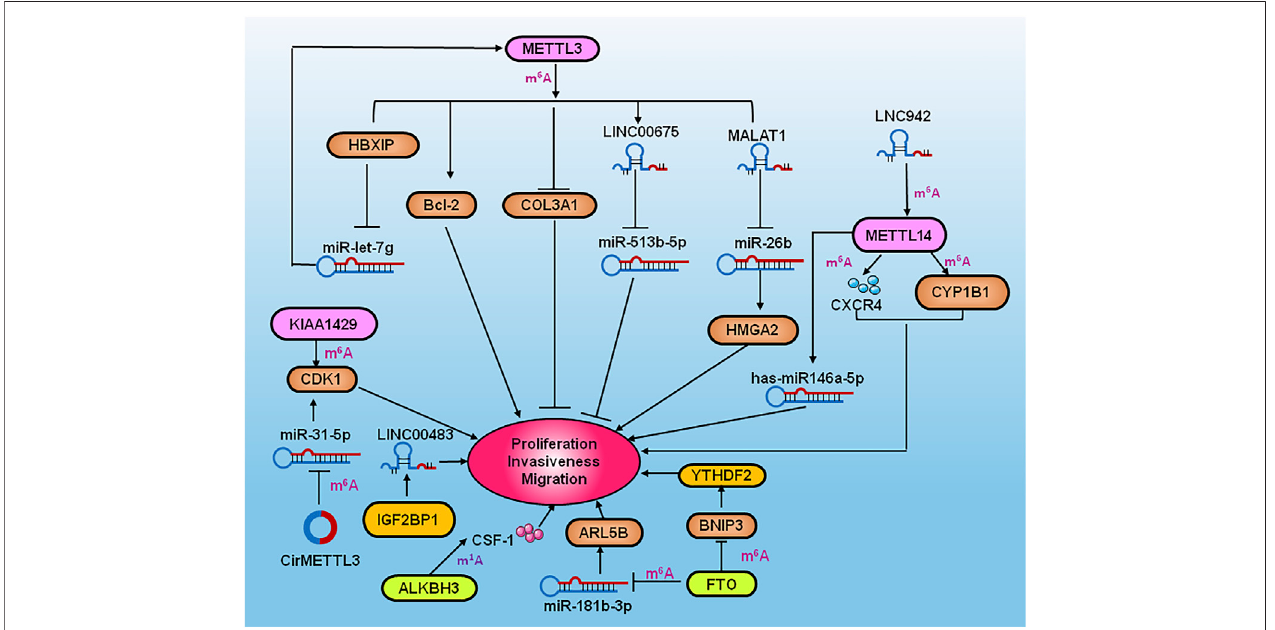
FIGURE 1 | Diagram of RNA modi fi cation regulators playing a vital role in the proliferation, invasion and metastasis of breast cancer. METTL3 promoted the proliferation, invasion and metastasis by targeting Bcl-2, while it reduced the expression of COL3A1 to inhibit the metastasis of breast cancer. LINC00675 m 6 A methylationinducedbyMETTL3resultedintheinhibitingmiR-513b-5ptosuppressmalignantphenotypebreastcancer.LncMALAT1increased/HMGA2 tofacilitatethe proliferation,invasionand metastasis ofbreastcancercellsbyinhibiting miR-26b. LNC942 directlybound toMETTL14resultinginregulationofm 6 Amethylationof CXCR4 and CYP1B1 and mediate the onset and development of breast cancer. METTL14 also increased the expression of has-miR-146a-5p to promote invasion and migration of breast cancer. The writer KIAA1429 promoted the proliferation and metastasis of breast cancer by regulating CDK1, whereas circMETTL3 promoted the progression of breast cancer cells by targeting miR-31-5p/CDK1. FTO enhanced ARL5B by down-regulating miR-181b-3p to promote the invasion and migration of breast cancer. It also mediated m 6 A demethylation by YTHDF2 to enhance the proliferation and metastasis of breast cancer via inhibiting BNIP3. IGF2BP1 promote proliferation of breast cancer by binding to LINC00483. ALKBH3 induced the decay of CSF-1 to promote breast cancer cell invasiveness.